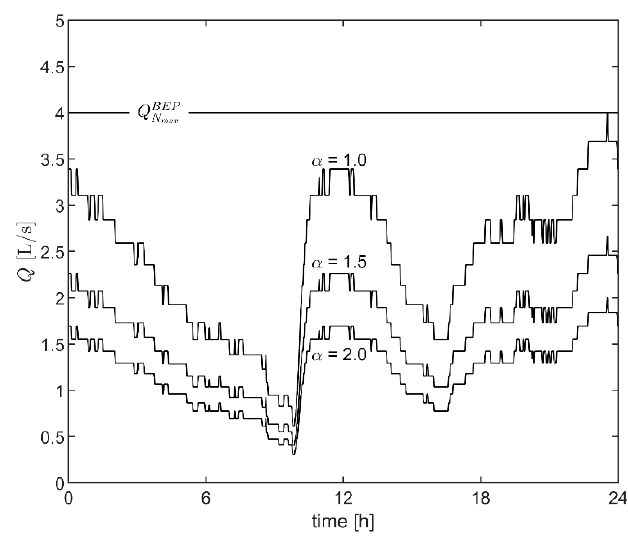
Figure 9. Design hydrographs for different values of 𝛼 .